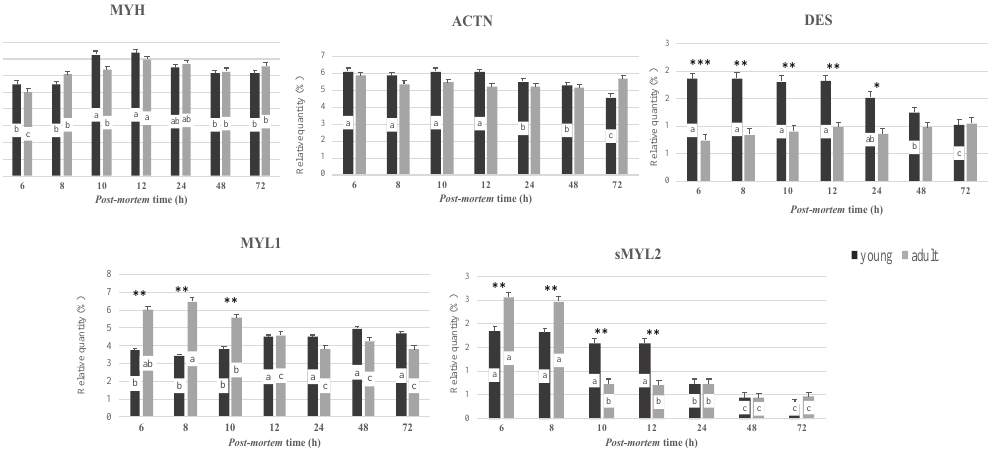
Figure 3. Representative SDS-PAGE (8 – 18%) and densitometric profile of myofibrillar proteins from the longissimus lumborum muscles of young and adult dromedaries after 6, 8, 10, 12, 24, 48 and 72 h postmortem (St = standard; MYH = myosin heavy chain; ACTN = α -actinin; DES = desmin; TNNT = troponin-T; TPM = tropomyosin; MYL1 = myosin light chain 1; TNNI = troponin-I; sMYL2 = slow myosin light chain 2; and fMYL2 = fast myosin light chain 2) .